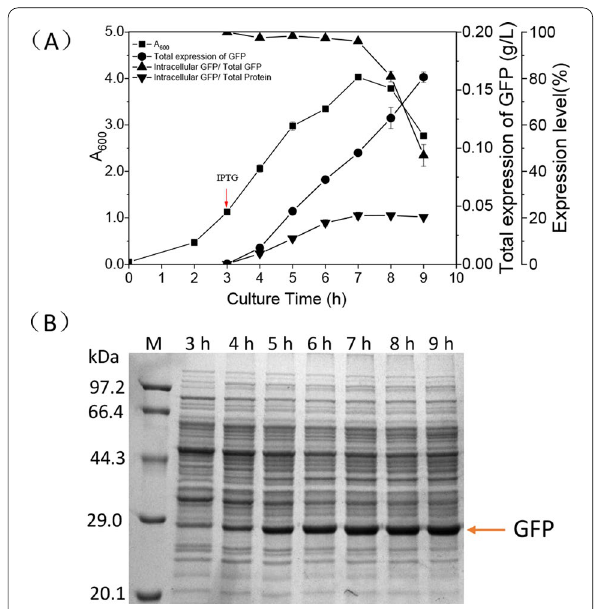
Fig. 3 Profile of fermentation of B. subtilis SCK22/pHT7‑GFP ( A ) and SDS‑PAGE analysis of GFP over time ( B )